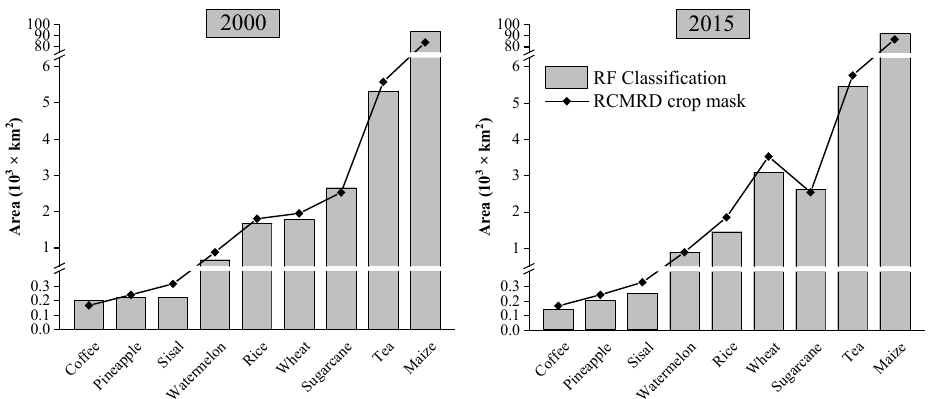
Figure 7. MOD13Q1: Acreage estimation of coffee, pineapple, sisal, watermelon, rice, wheat, sugar- cane, tea, and maize in Kenya using RF classification and RCMRD crop mask.